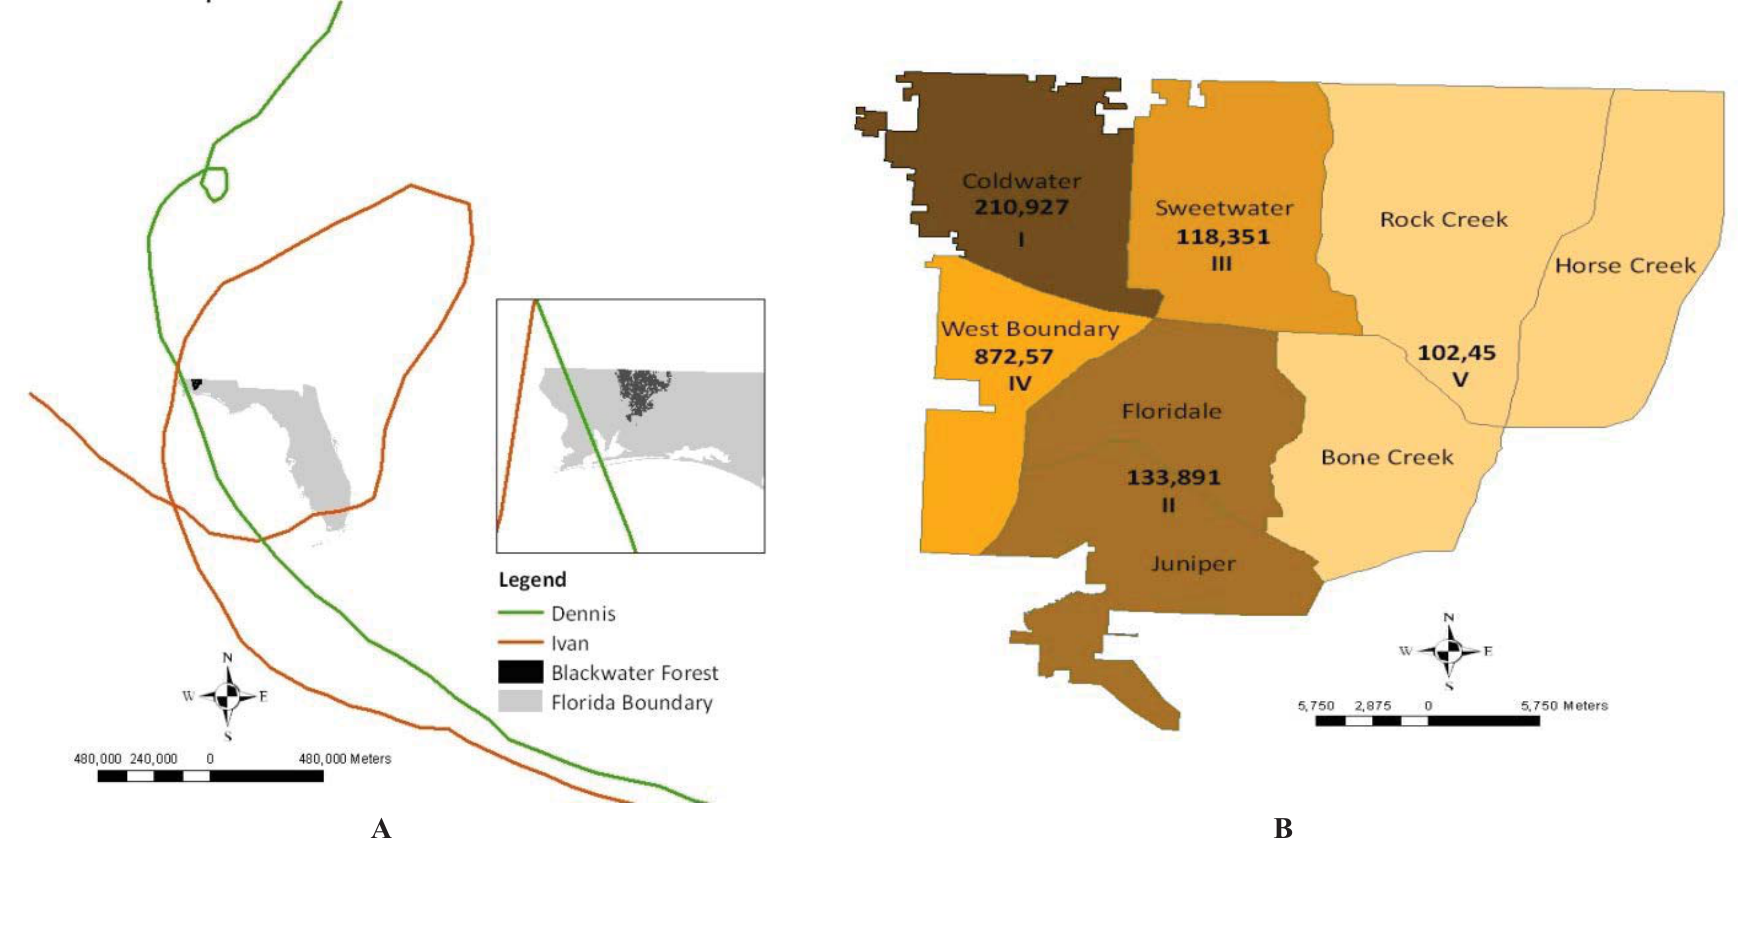
Figure 3. Map of Blackwater River State Forest depicting paths of Hurricanes Ivan and Dennis ( A ), biomass removal following Hurricane Ivan in 2005 ( B ) and Euclidian distance from Ivan overlaid on the biomass removal map ( C